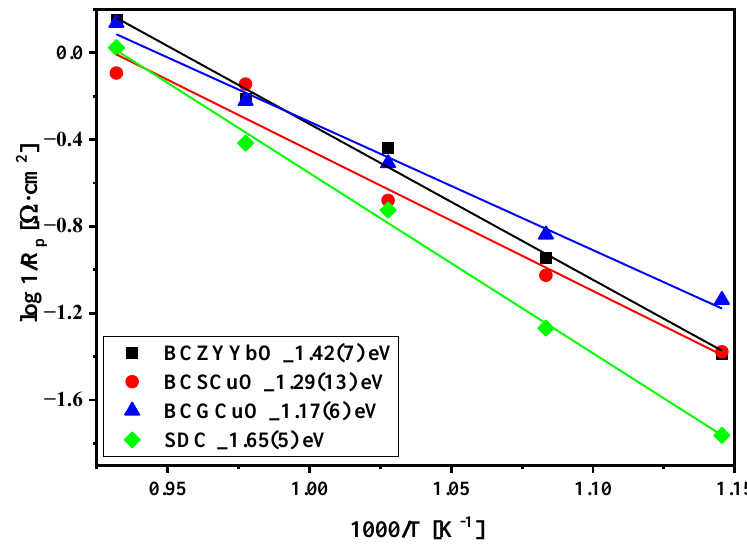
Figure 12. Temperature dependencies of the polarization conductivity obtained by the impedance spectroscopy method for the symmetrical cells with the NCNCO02 functional layer in contact with different solid-state electrolytes.